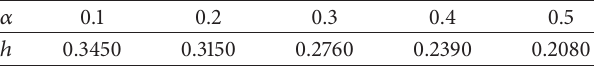
Table 1: Maximum values of the upper bound ℎ for different 𝛼